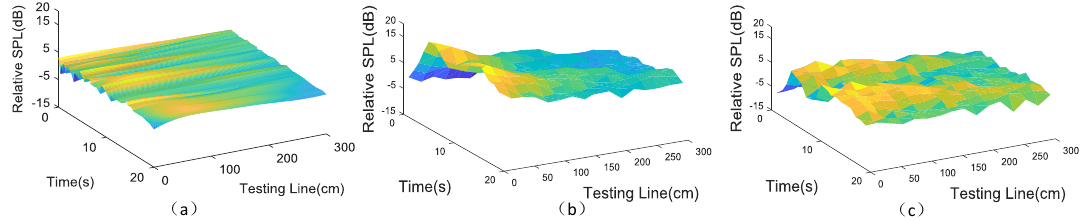
Figure 8. The results of simulation and experiments. ( a ) Simulated distribution of relative SPL. ( b ) Non- optimized time-varying distribution of SPL. ( c ) Optimized time-varying distribution of